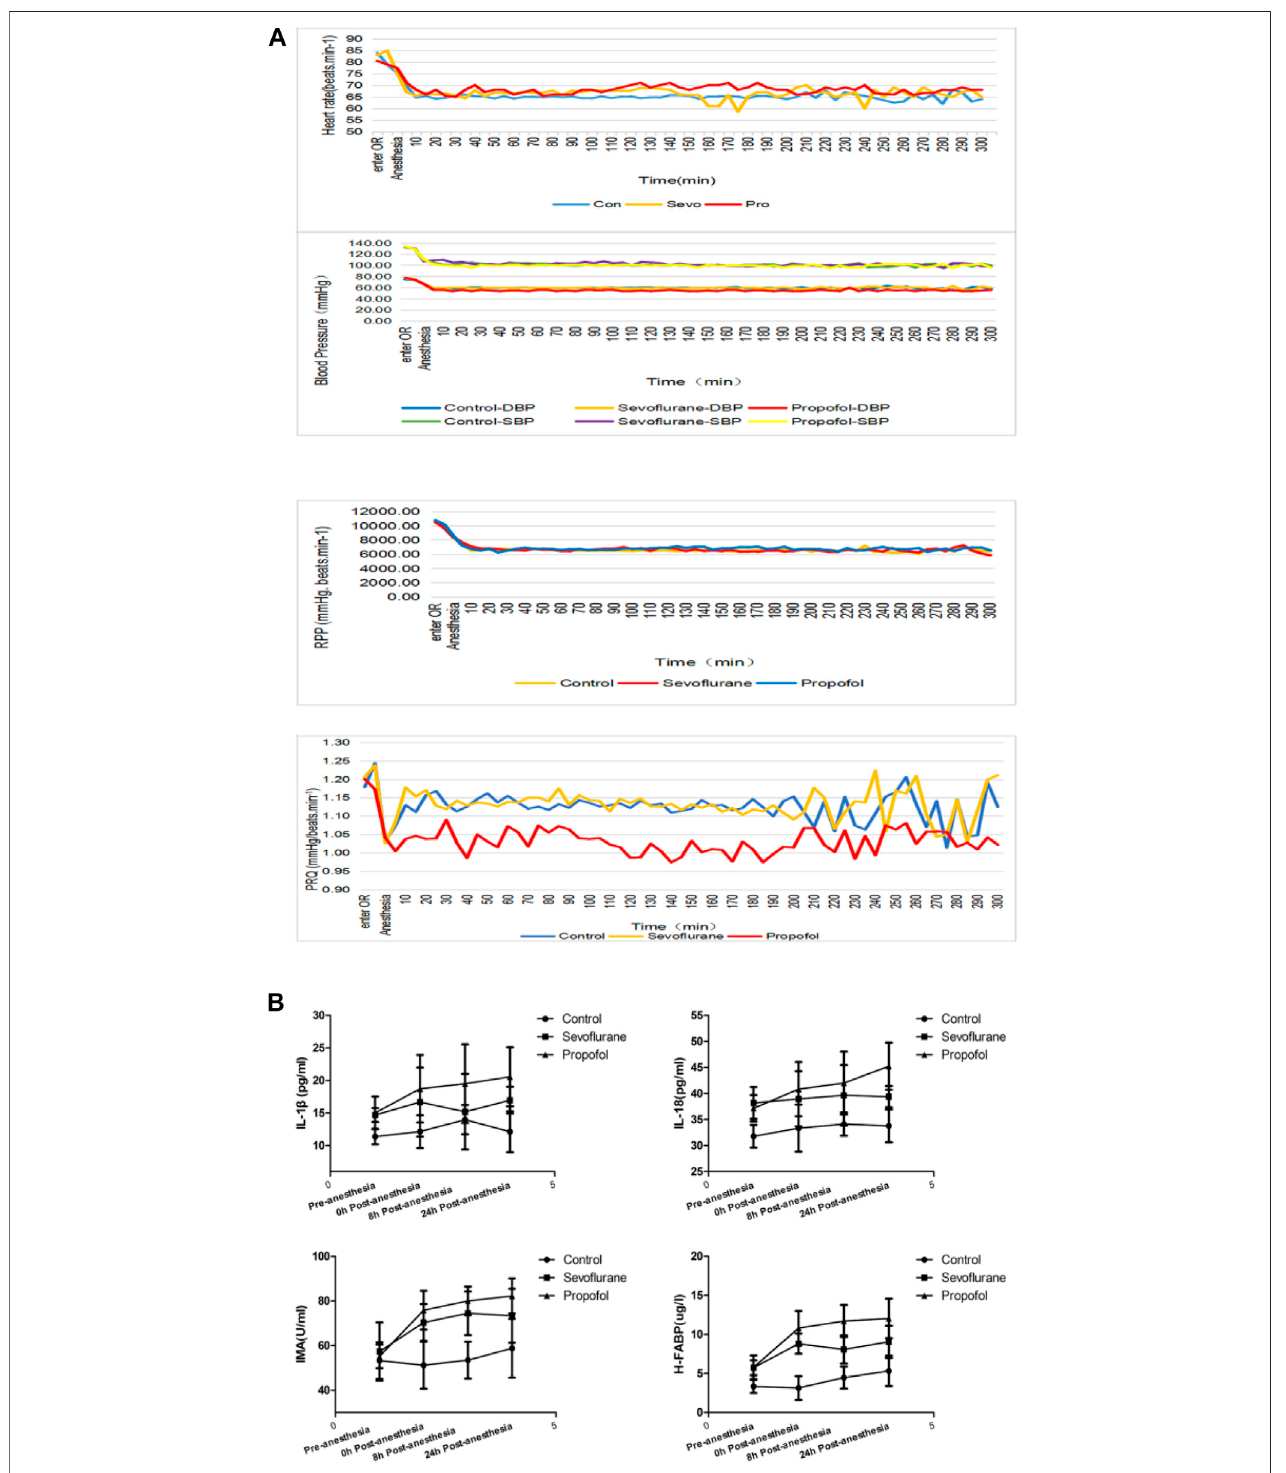
FIGURE 2 | Changes in vital signs and in fl ammatory factors in these three groups of patients (A) different general anesthetics on the changes of heart rate, blood pressure, RPP and PRQ in peri-anesthesia in the three groups (B) Changes of IL-18 at different time points at pre- and post-anesthesia.